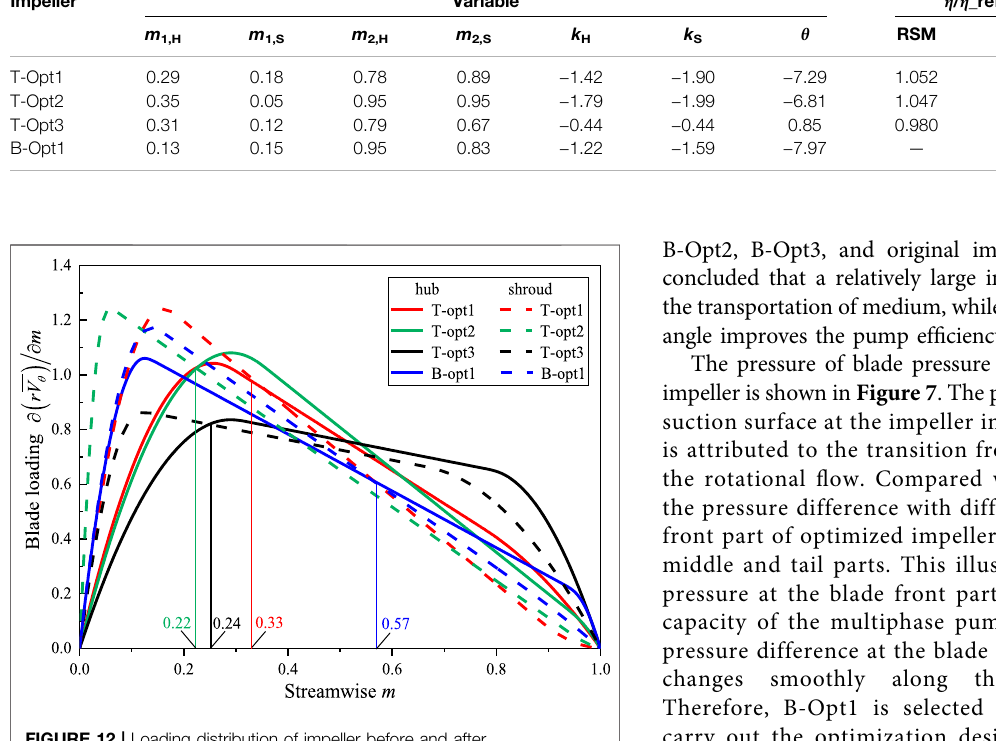
FIGURE 12 | Loading distribution of impeller before and after optimization.